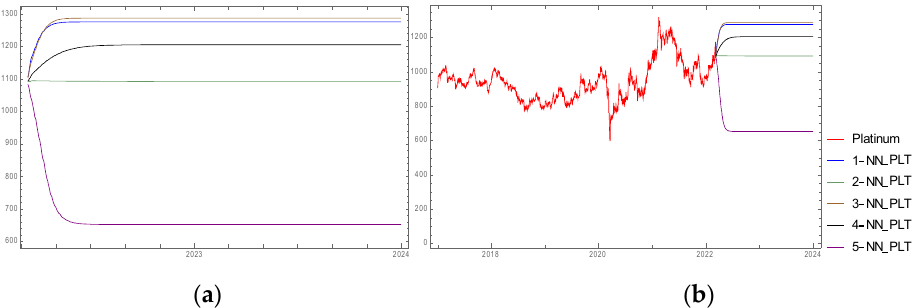
Figure 7. Prediction of future development of platinum prices till the end of the year 2023 ( a ) future development of platinum price according to the best neural networks, ( b ) past development of platinum price with its future development according to the best neural networks.